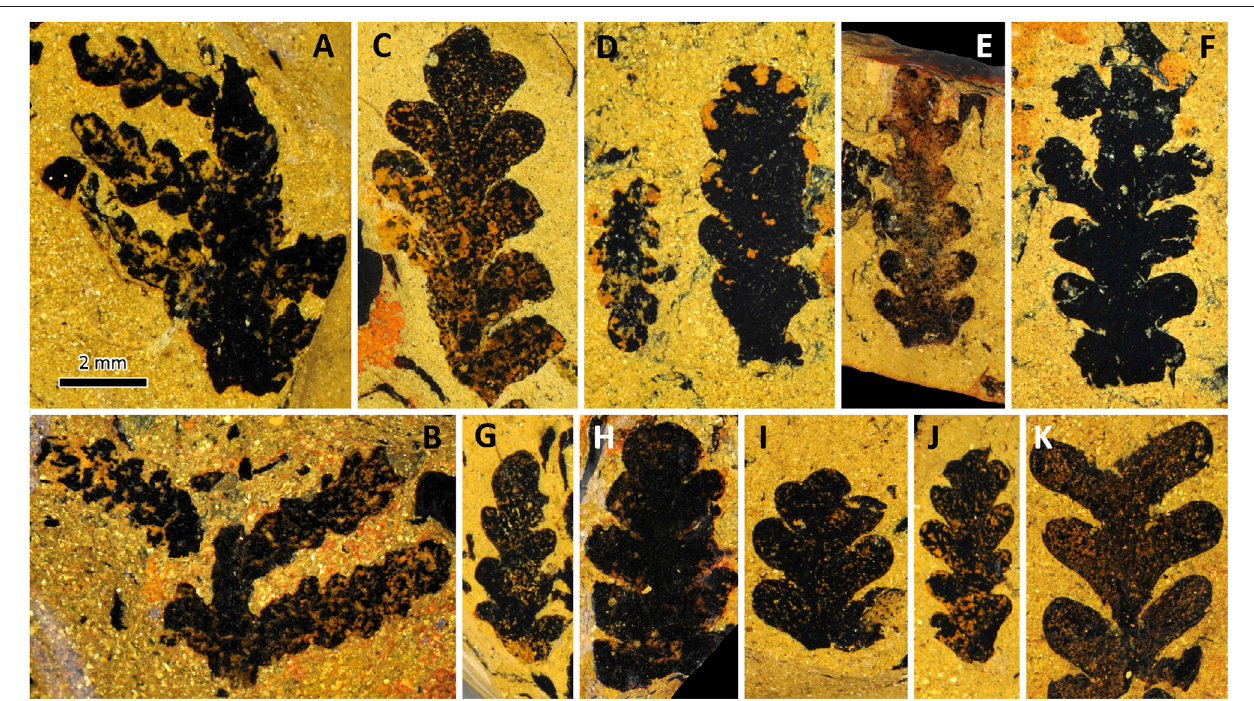
FIGURE 4 | Light photographs of Germaropteris martinsii from the upper Permian Kayitou Formation of Southwest China. (A,B) Penultimate fronds showing alternately attached ultimate pinnae. (C – E,G – I) Ultimate pinnae showing the overtopped apices in different modes. (F) Ultimate pinna; note that the pinnules gradually decreaseinsizedistallyandbasally. (J) Immatureultimatepinnashowingtightlyarrangedandalternatelyattachedpinnules. (K) Relativelymatureultimatepinnashowing loosely spaced and sub-oppositely attached pinnules. Scale bar applies to all images. Specimen no. YNUPB10110-120.